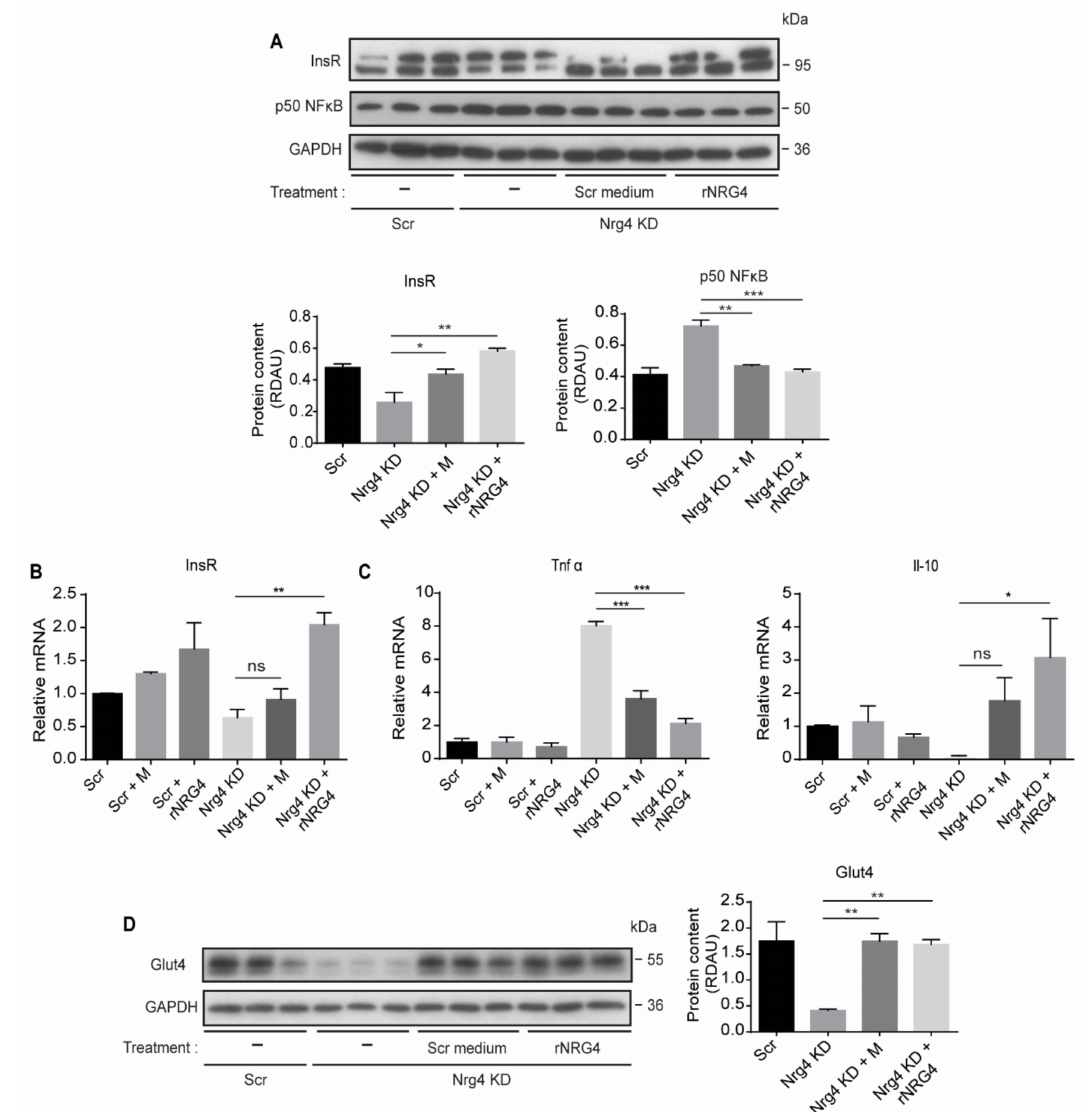
Figure 4. Human recombinant Nrg4 and Scr conditioned medium treatment of Nrg4 KD adipocytes restores Glut4 and InsR protein content and reverses cell-autonomous inflammation. Adipocytes were treated with 2 mL of conditioned medium from Scr D7 adipocytes, or with 50 ng/mL rNRG4 at D5 for 48 h. ( A ) Western blot bands and quantification of p50 NF- κ B and InsR proteins in non-treated Scr adipocytes, and in non-treated, Scr conditioned medium (M)- or recombinant Nrg4 (rNRG4)-treated Nrg4 KD adipocytes at day 7 (D7) of differentiation ( n = 3). The lower band of the InsR blot was quantified. ( B ) InsR expression in non-treated, Scr M or rNRG4-treated Scr, and Nrg4 KD adipocytes at D7 ( n = 3). ( C ) Tnf α and Il-10 expression in non-treated, Scr M, or rNRG4-treated Scr and Nrg4 KD adipocytes at D7 ( n = 3). All the qPCR data were normalized to non-treated Scr adipocyte expression at D7. ( D ) Western blot bands and quantification of Glut4 in non-treated Scr adipocytes, and non-treated, Scr M-, and rNRG4-treated Nrg4 KD adipocytes at D7 ( n = 3). In the western blots, GAPDH was used as a loading control. Overall contrast and brightness of the western blot were adjusted to clarify the images. Data represent mean ± SEM. * p ≤ 0.05, ** p ≤ 0.01, *** p ≤ 0.001, ns (not